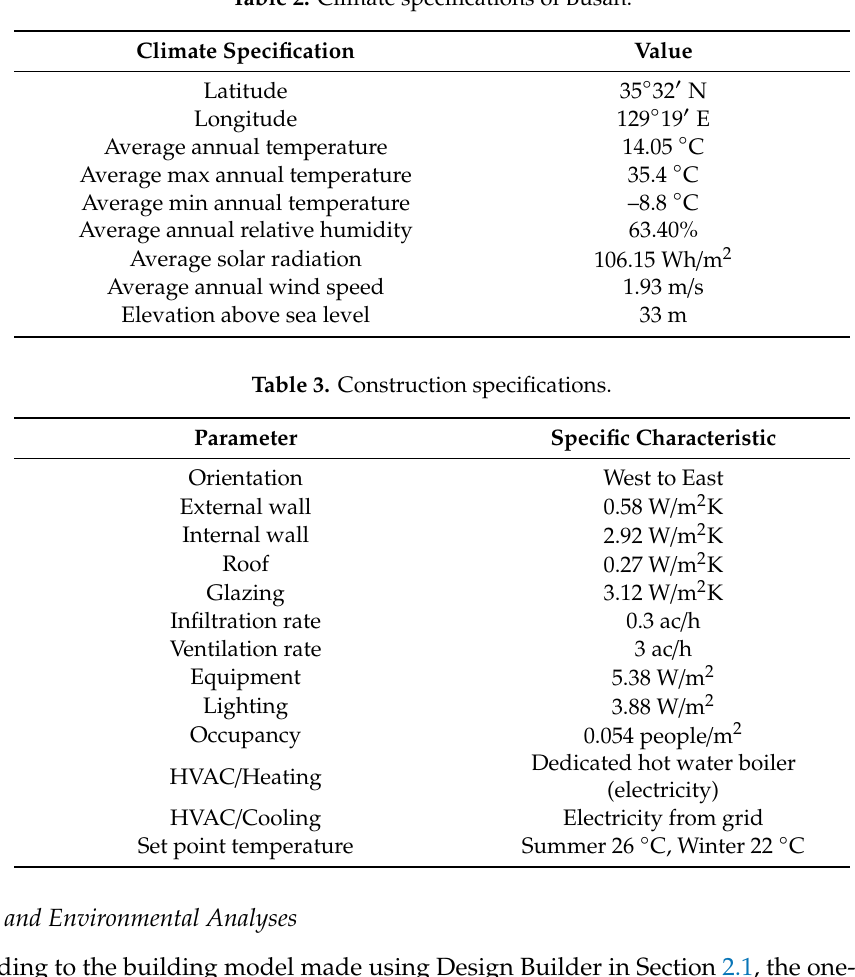
Table 2. Climate specifications of Busan.